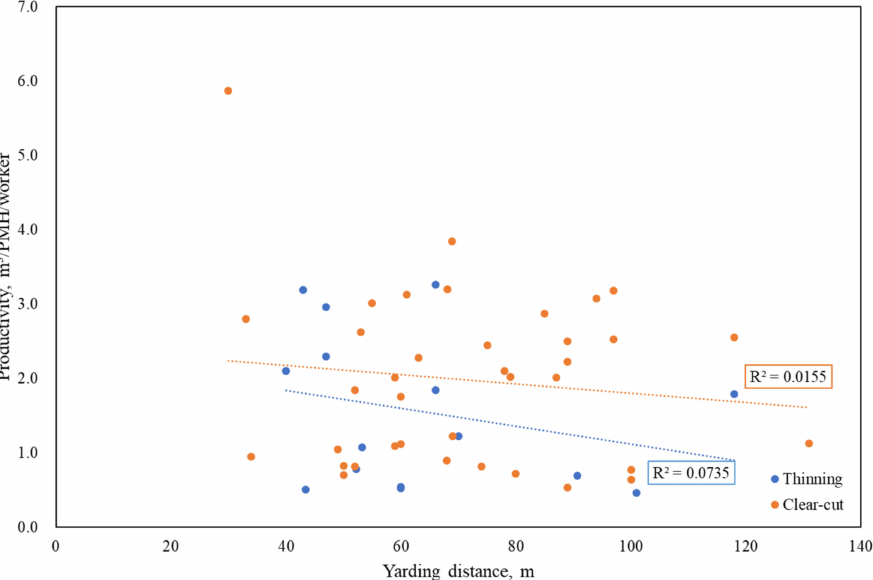
Figure 8. Productivity relationship with the yarding distance, and it had a weak-to-moderate (thinning operations) or small (clear-cut activities) negative